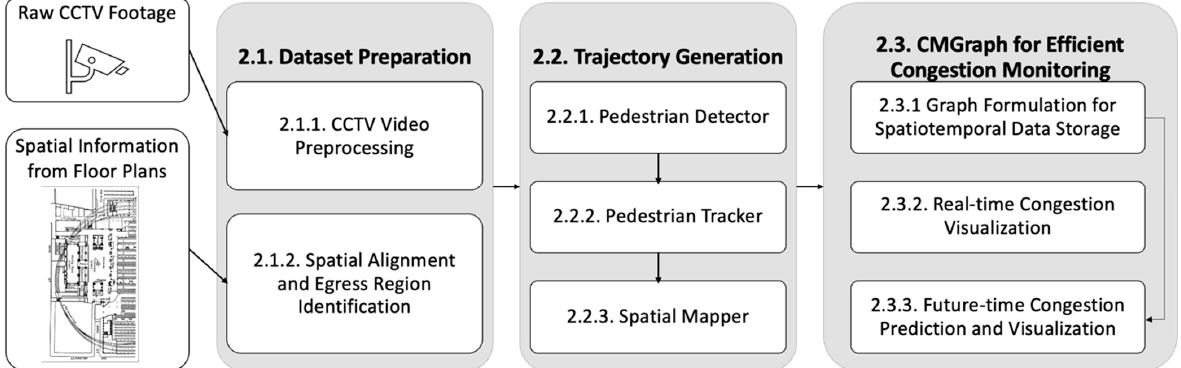
Figure 1. Workflow of the congestion monitoring framework.